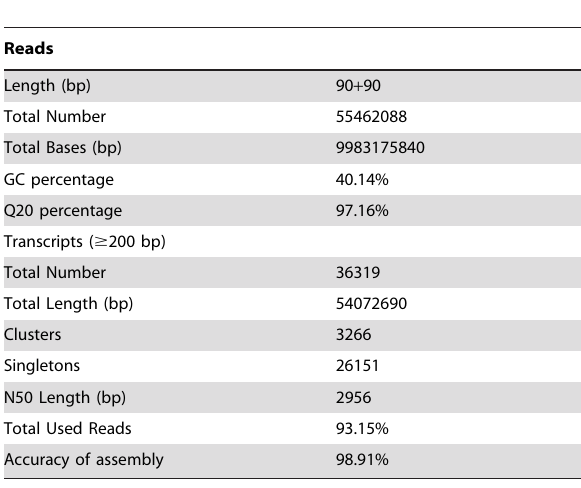
Table 1. Summary of sequencing and assembly for S.